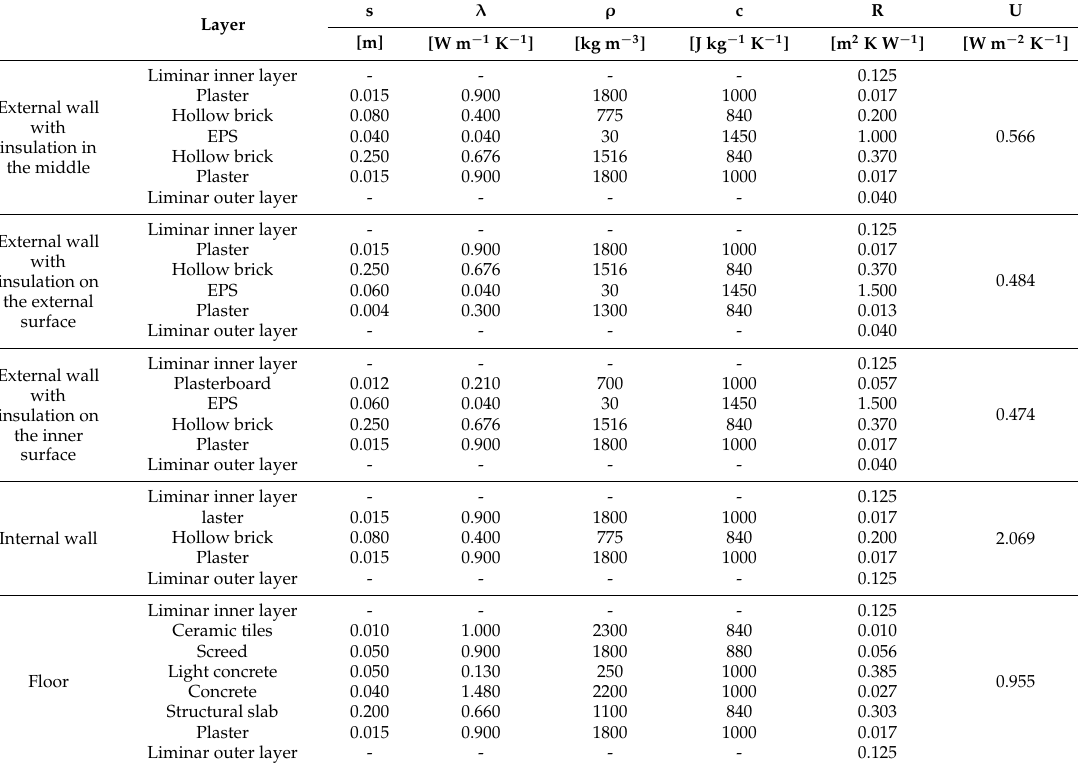
Table A2. Stratigraphy and thermal properties of the structures of the insulated buildings (IM, IE, and